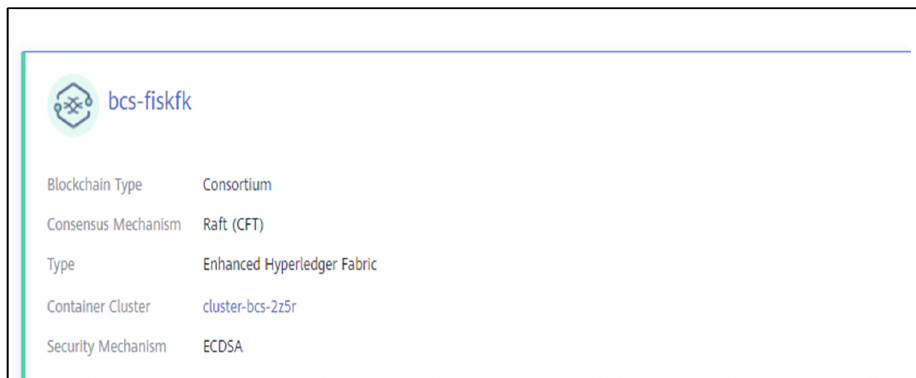
Figure 12. CBSC Configuration.